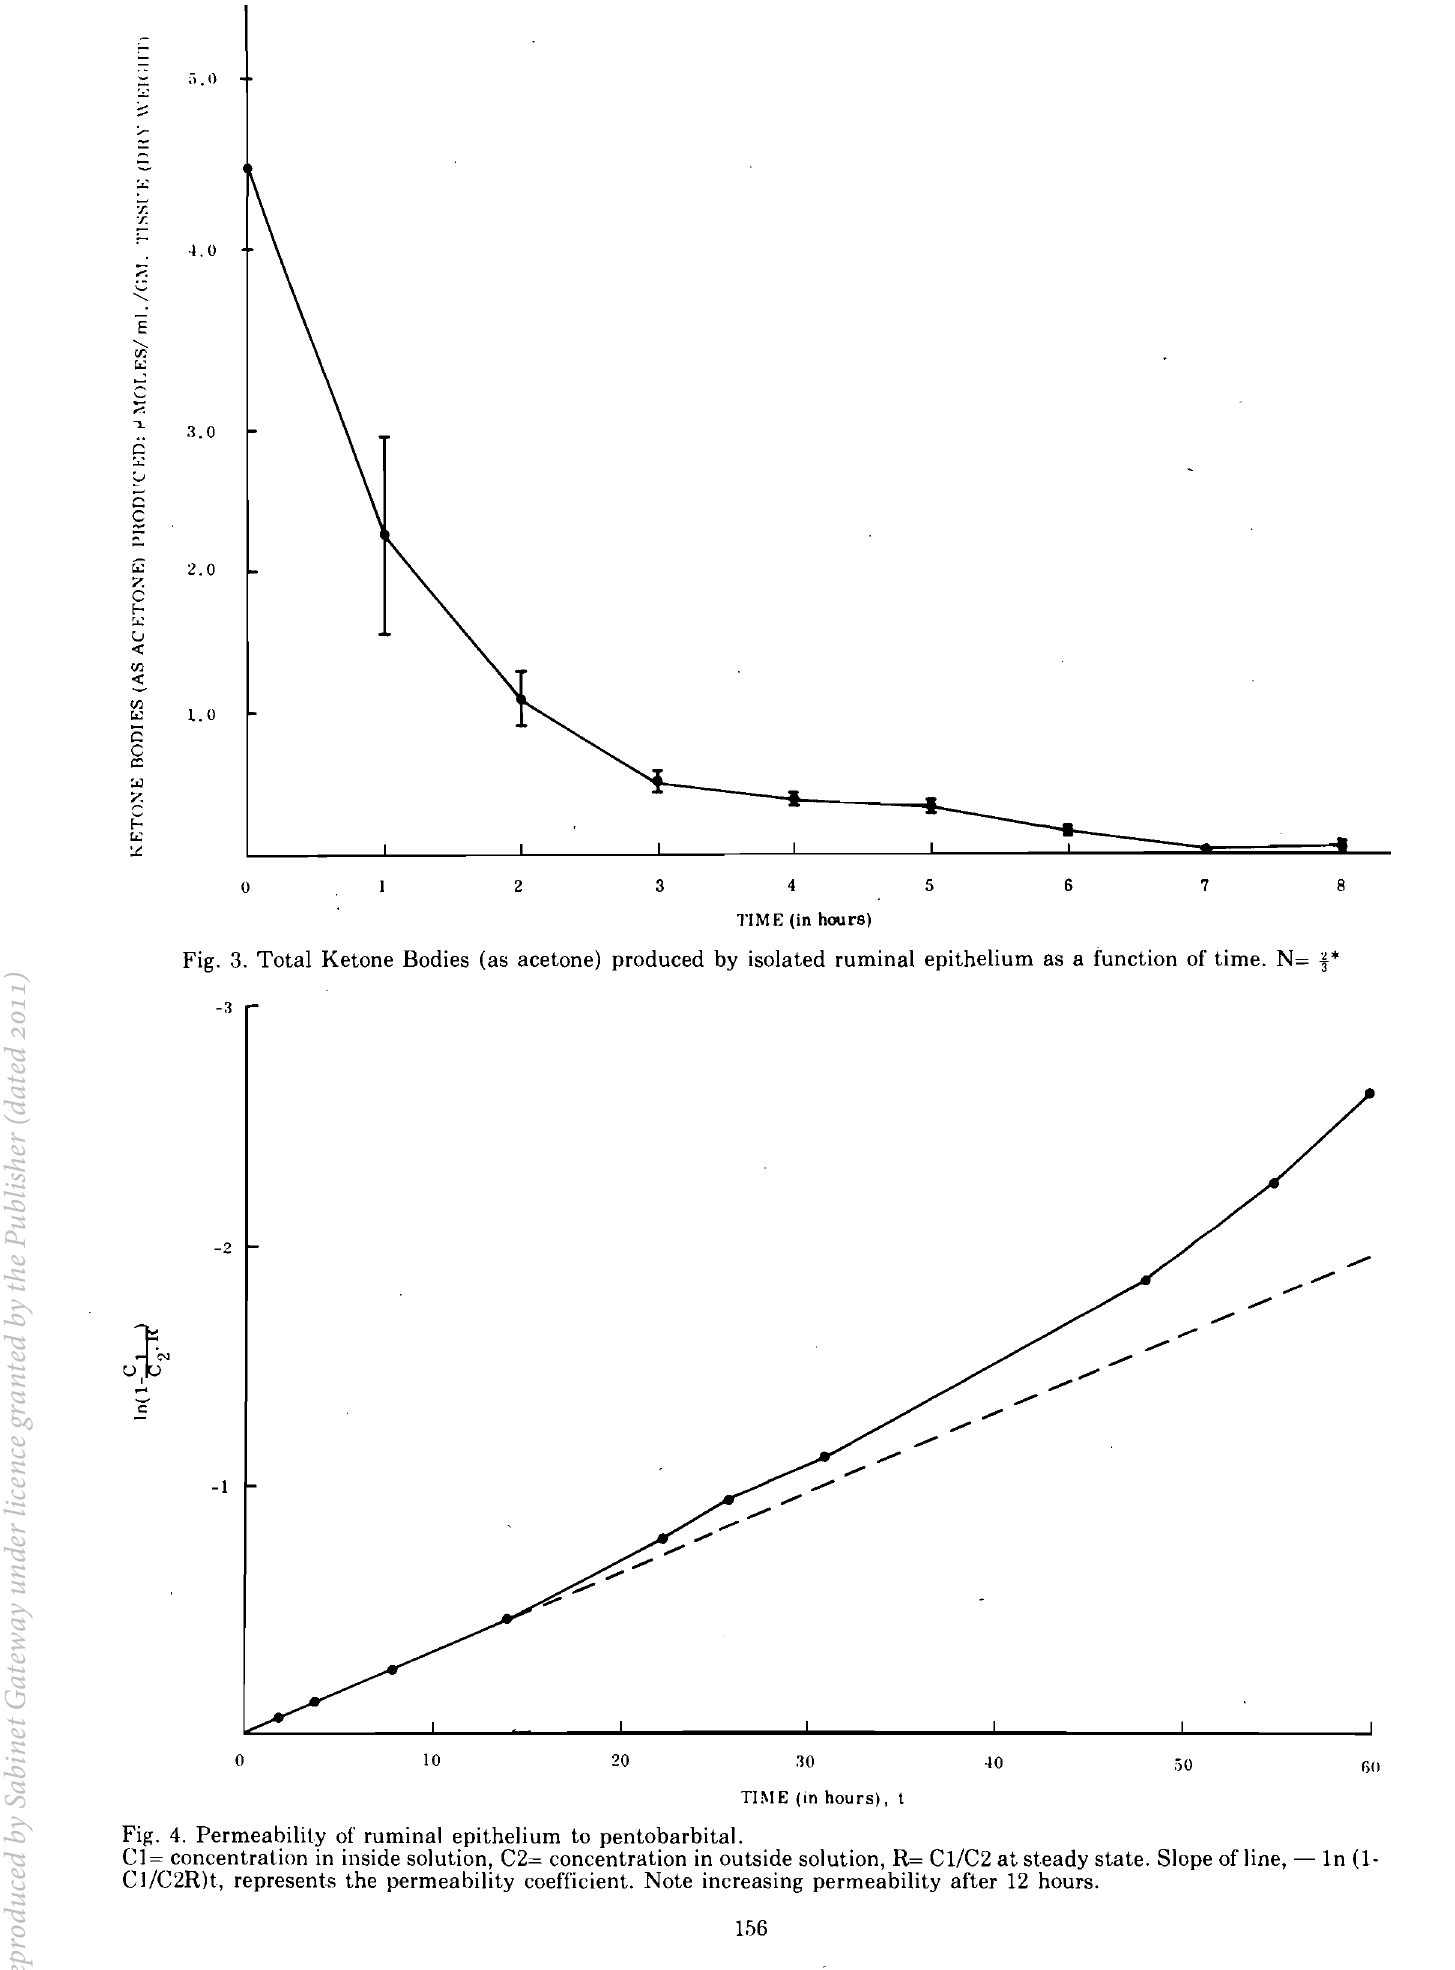
Fig. 4. Permeability of ruminal epithelium to pentobarbital. Cl= concentration in inside solution, C2= concentration in outside solution, R= Cl/C2 at steady state, Slope of line, -In (1- Cl/C2R)t, represents the permeability coefficient. Note increasing permeability after 12 hours.